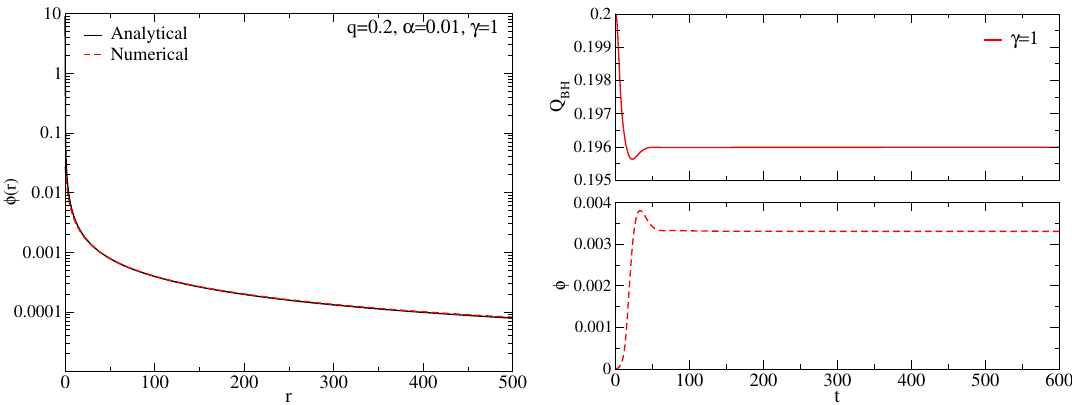
Figure 5 . (Left panel) Radial pro(cid:12)le of the scalar (cid:12)eld (cid:30) ( r ) at t = 600 for the initial data consisting of a RN BH with a small dilaton Gaussian pro(cid:12)le. There is an excellent matching between the pro(cid:12)le obtained from the numerical evolution and the pro(cid:12)le of a AAM BH with the same q and r H . (Right panels) Time evolution of the electric charge at the horizon Q e and the amplitude of the scalar (cid:12)eld extracted at r 0 = 11 :